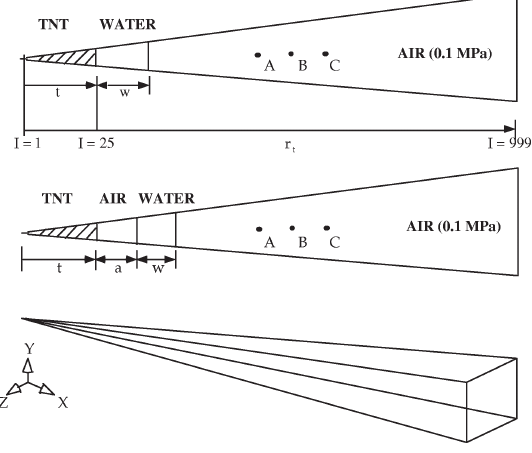
Fig. 3. Spherically symmetric one-dimensional model setup.